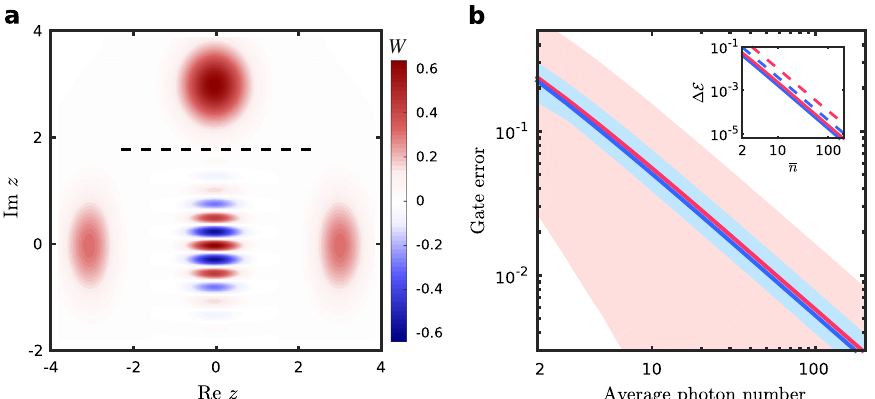
(cid:2) (cid:6) (cid:2) that minimize the average error of 0 = θ /(6 g ), θ is T